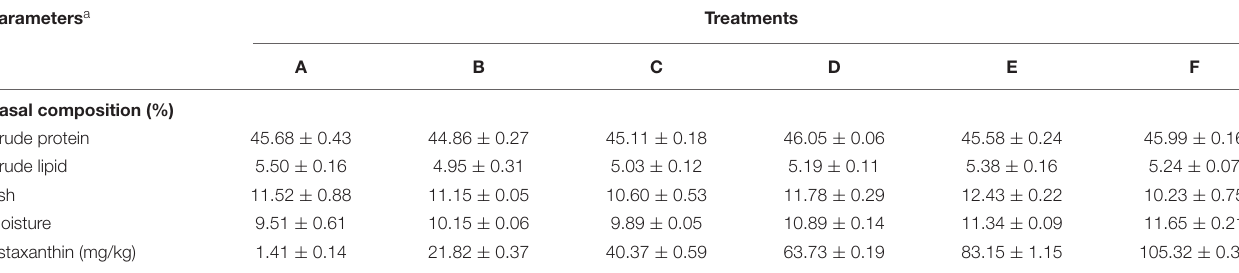
TABLE 2 | Proximate and carotenoid composition of the experimental diets. Parameters